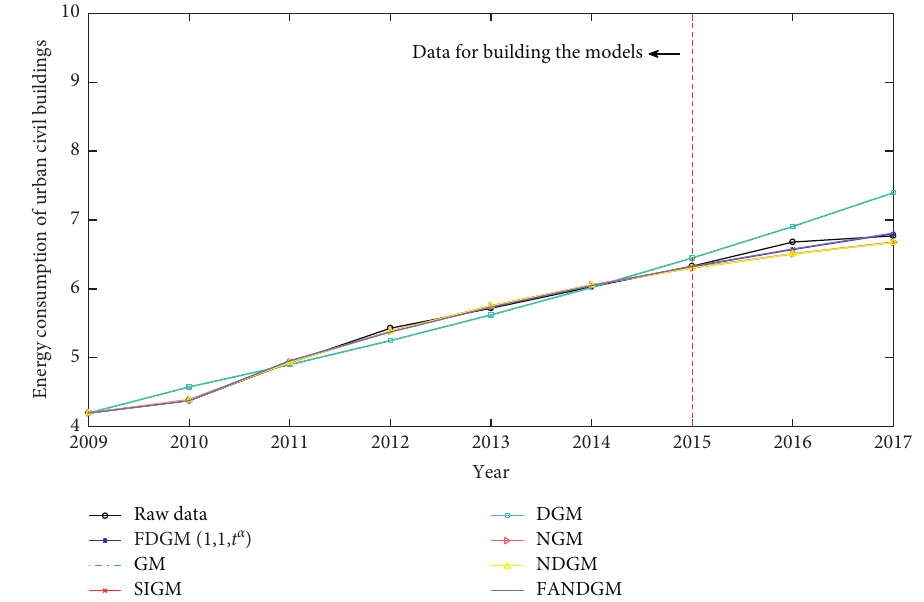
Figure 8: Results of energy consumption of urban civil buildings. Table 4: Fitting results and prediction results of energy consumption of urban civil